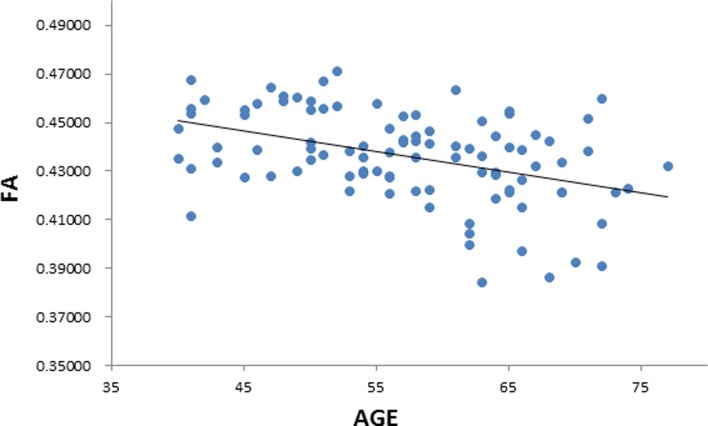
Negative correlation between age and fractional anisotropy (FA).Scatterplot with regression line.